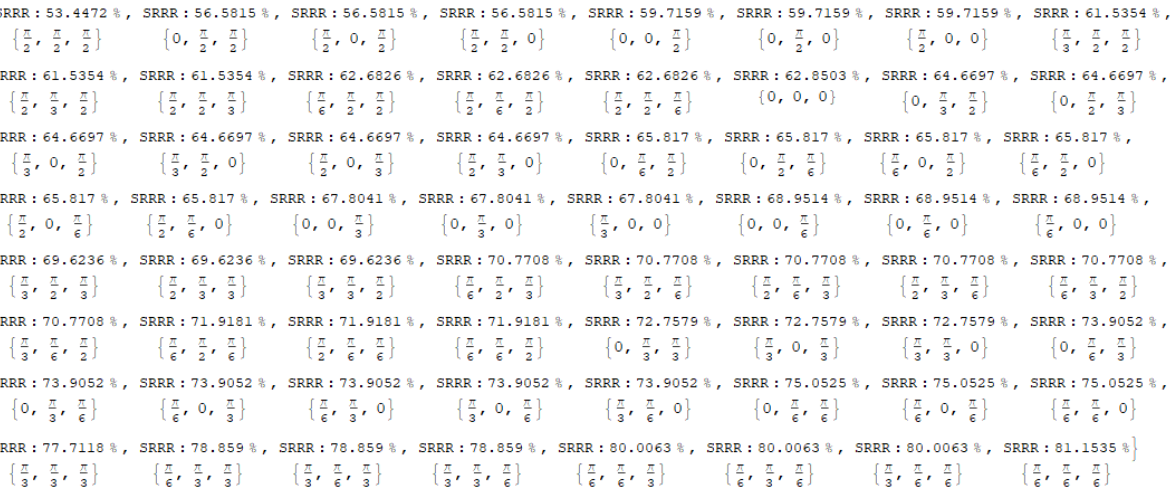
Makkah, Saudi Arabia.